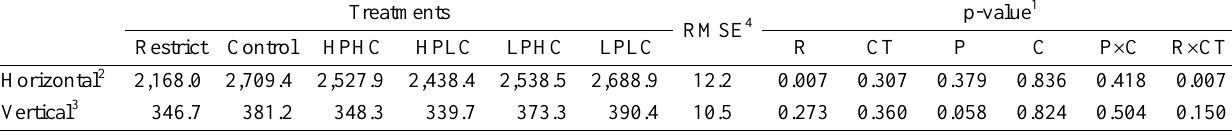
Table 5. Effect of nutritional plan (least square means, m) on horizontal and positive vertical locomotion